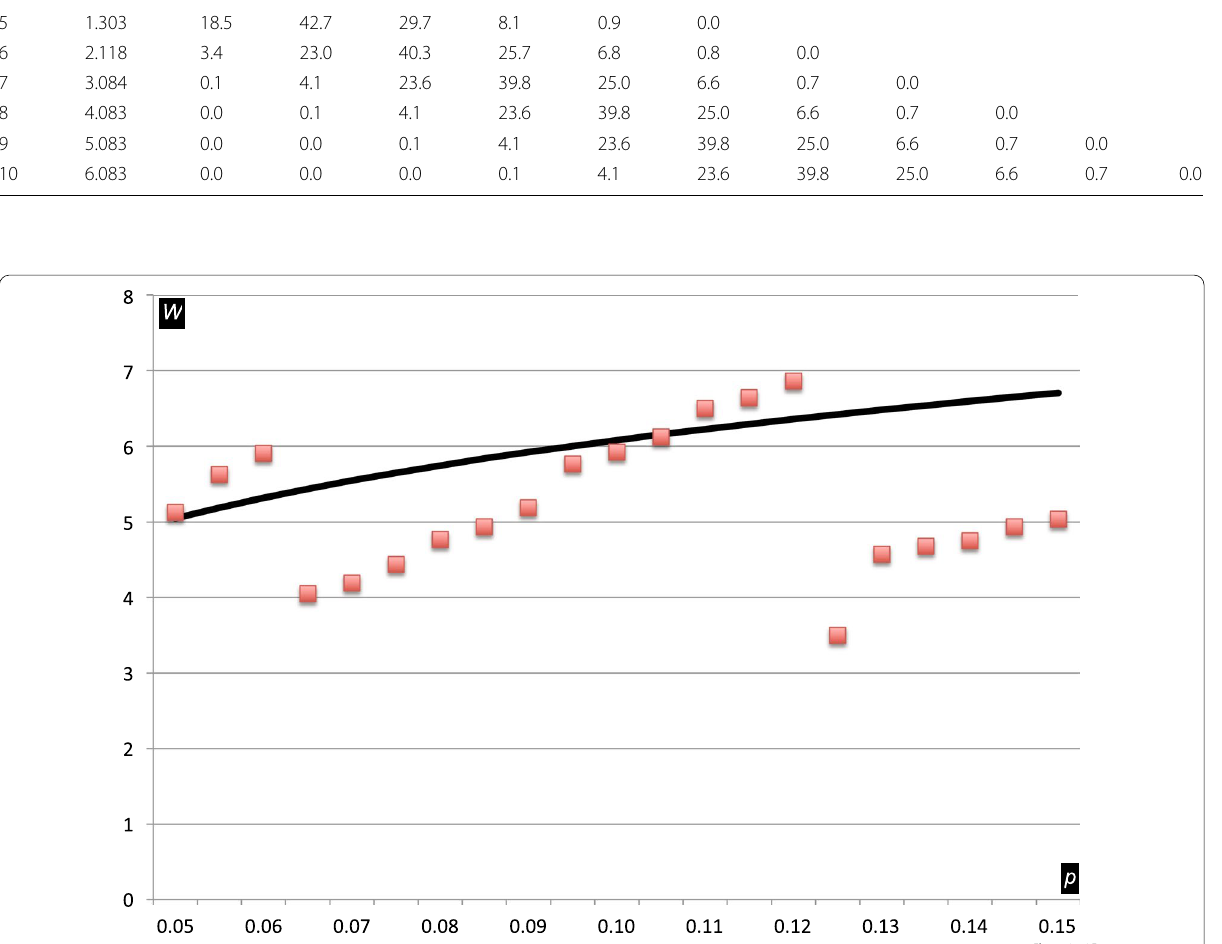
Fig. 7 Mean path weights. The curve: sparse MT, n = 1024 . Scattered dots: average path weight of a truncated, dense MT with 2 ⌈ log 2 ( np ) ⌉